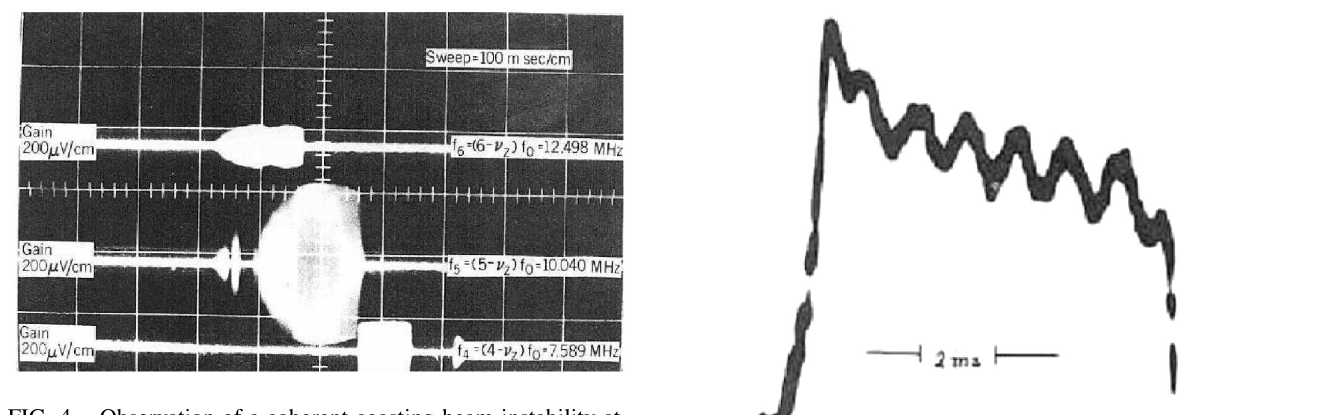
FIG. 4. Observation of a coherent coasting-beam instability at the Bevatron in 1971; oscilloscope traces show the amplitudes of modes 6, 5, and 4 as a function of time; sweep time is 100 ms per cm [21].